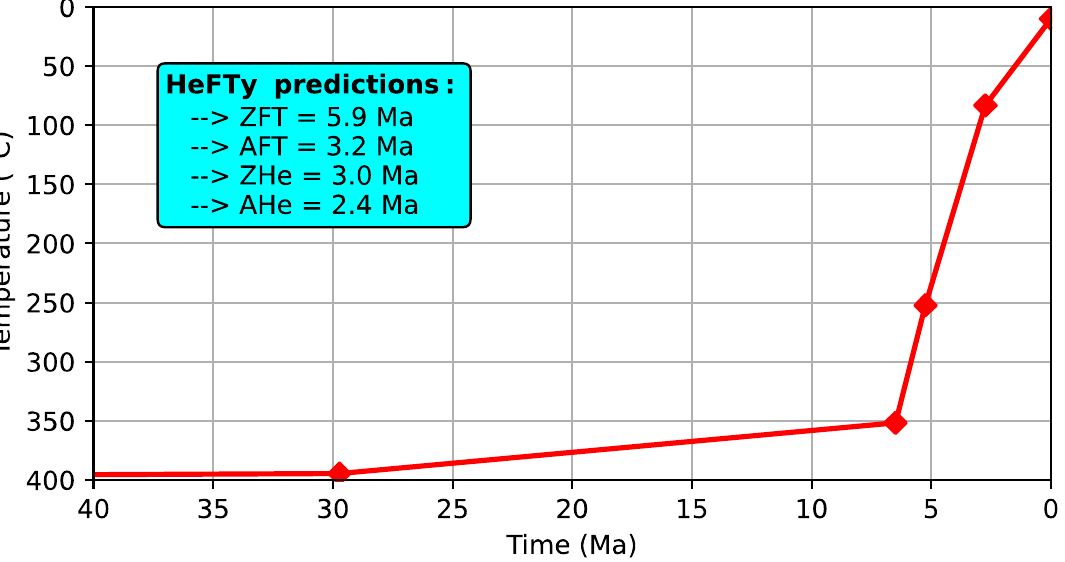
Figure 5. Time-temperature path used in HeFTy [44] to predict AHe, ZHe, AFT, and ZFT ages (in the blue box) using the model and model parameters of RDAMM [13], ZRDAAM [15,51] and the parallel curvilinear model of [51], respectively. This time–temperature path is an adaptation for higher closure temperature systems of the time temperature paths proposed for the southern Abancay Deflection by [27].